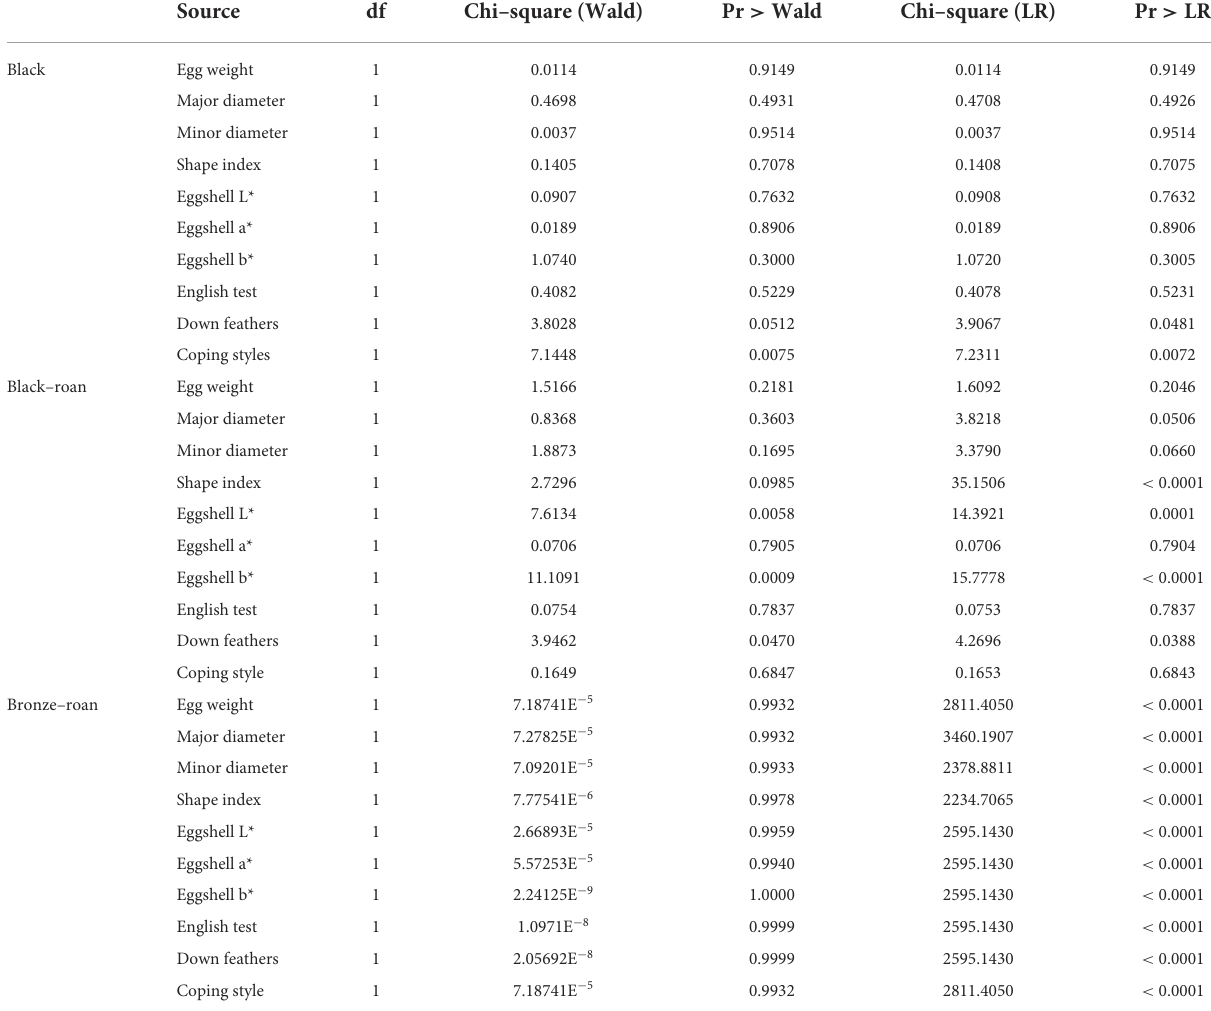
TABLE 4 Summary of the results for strength of association between the plumage varieties of the Andalusian turkey breed and the ability to succeed or fail when assigning sex for the different methods using the chi–square independence test. Source df Chi–square (Wald) Pr > Wald Chi–square (LR) Pr >